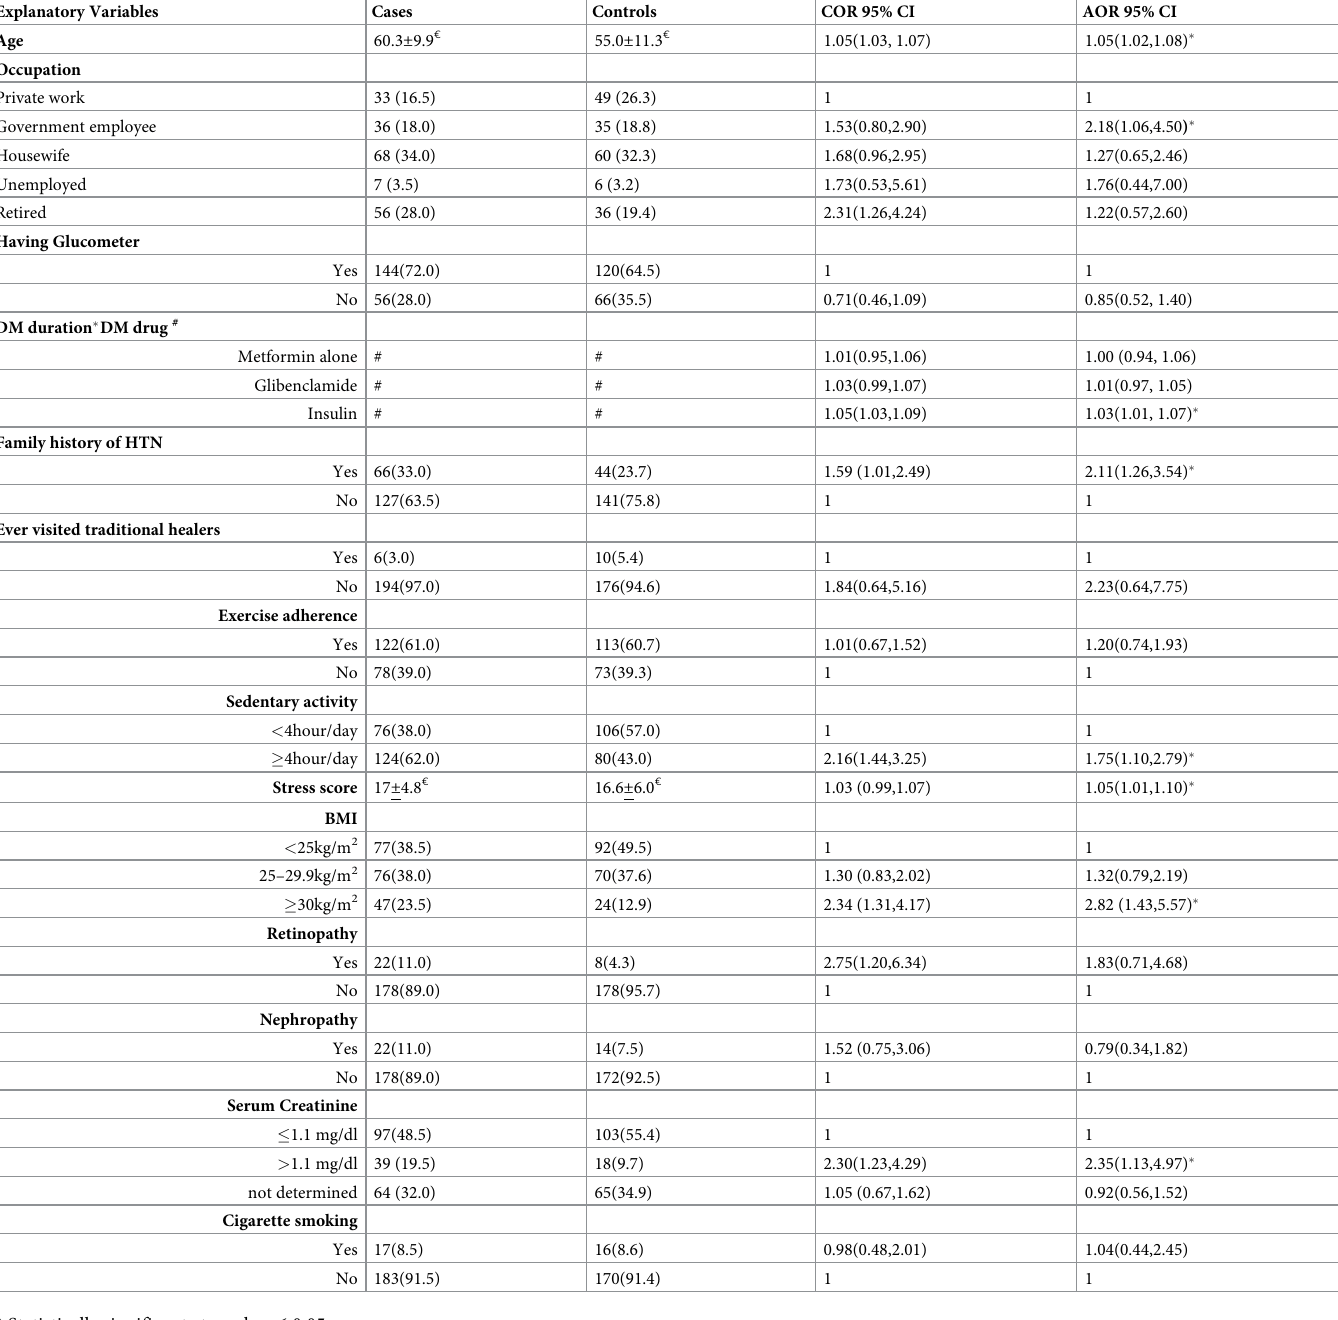
Table 3. Bivariable and multivariable logistic regression analyses results of factors associated with hypertension among people with T2DM on follow-up at TASH hospital, Addis Ababa, Ethiopia,